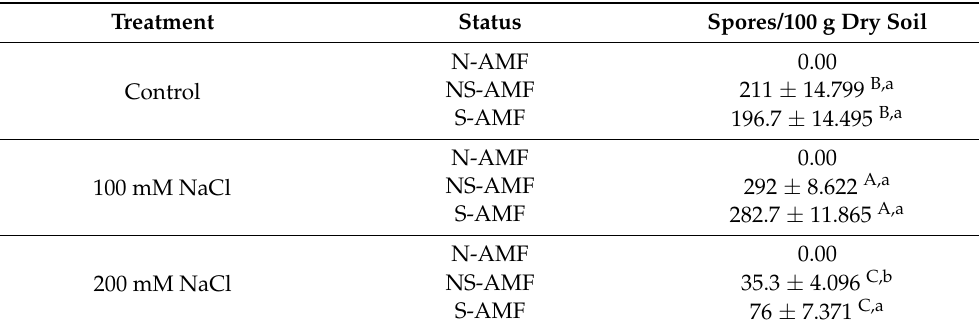
The first line indicates mean value and the second line indicates ± SE. Capital letters indicate the significance of the salinity effect, while small letters indicate the effect of AMF at p = 0.05 (Tukey’s HSD test).